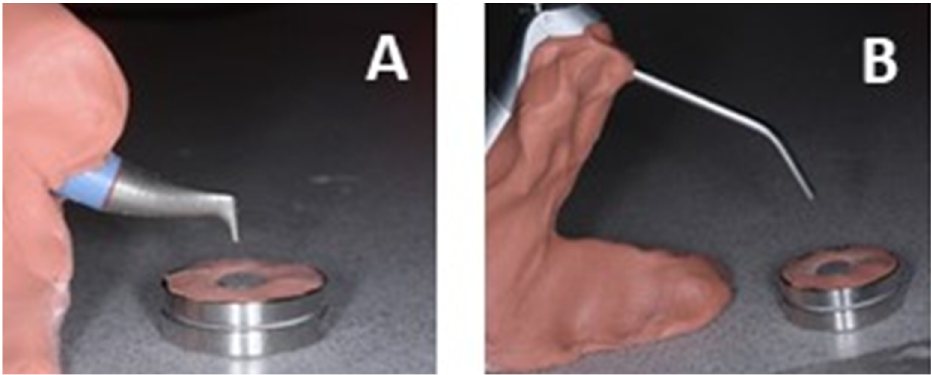
Figure 2. ( A ) Handpiece at 90° angle and 5 mm distance from the disc receiving treatment. ( B ) Triplex Syringe at 2 cm from the disc receiving treatment.